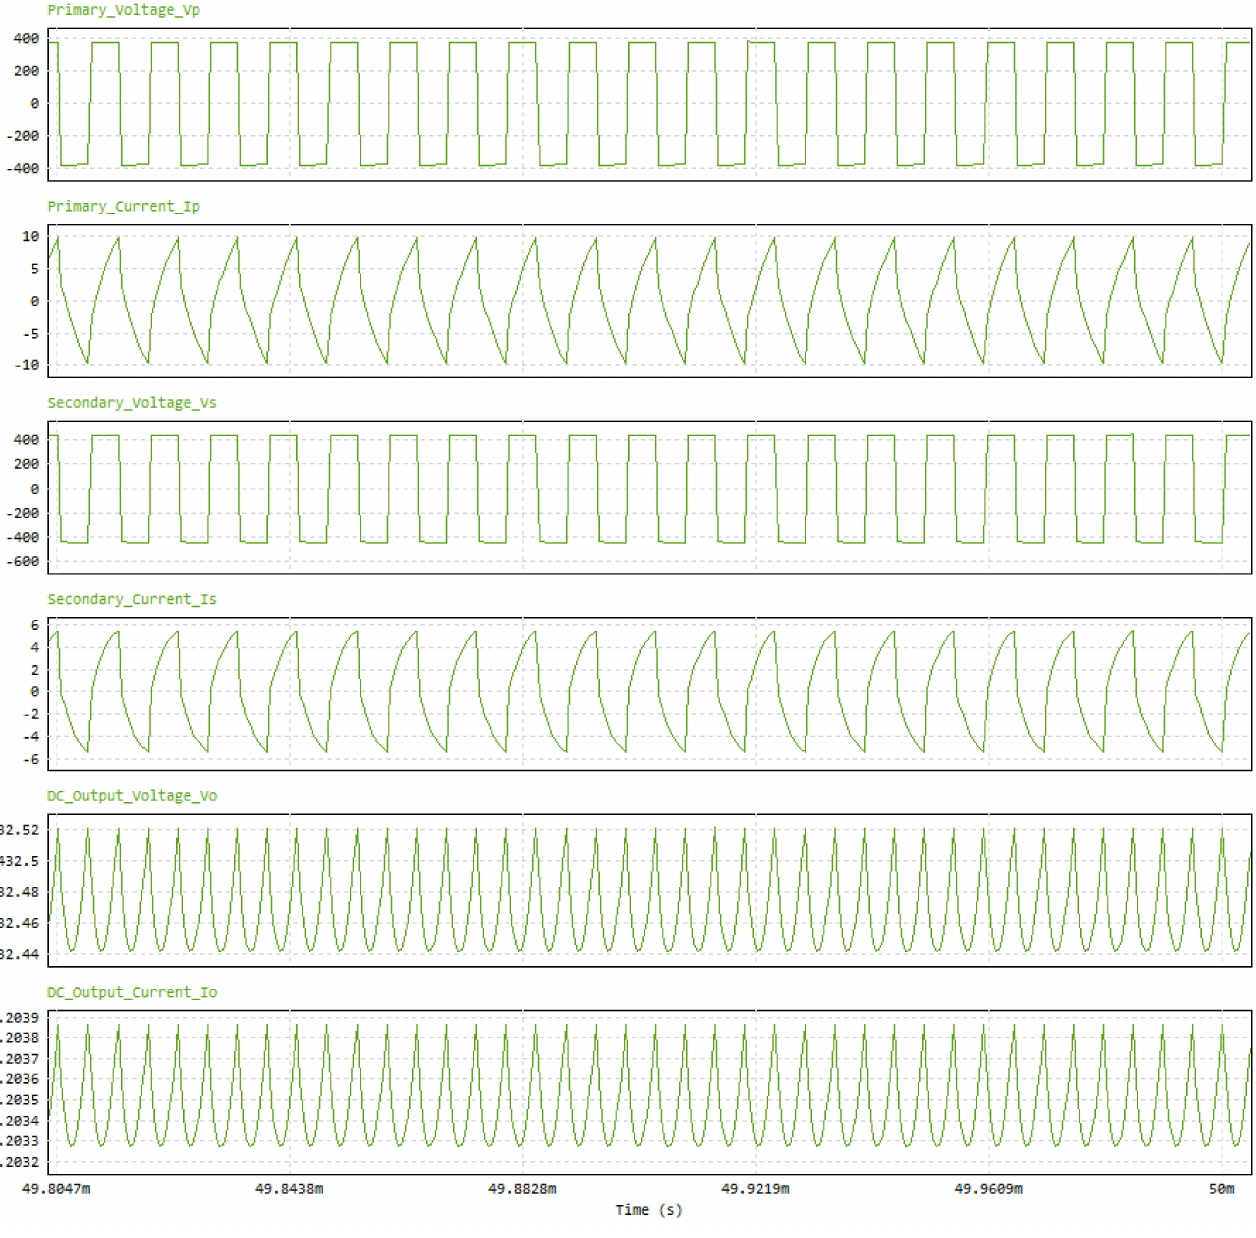
Figure 22. Simulation results of the DC–DC